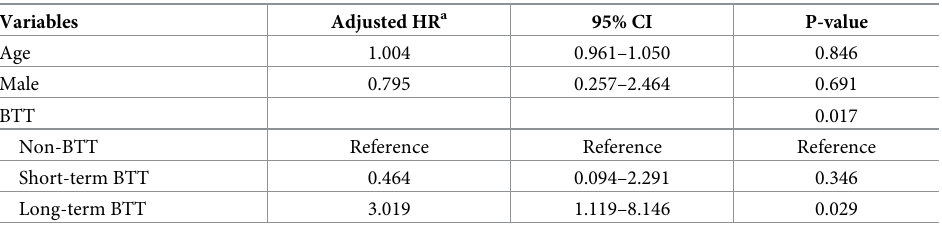
BTT, bridge to lung transplantation; CI, confidence interval; HR = hazard ratio. a Adjusted for age, sex, and